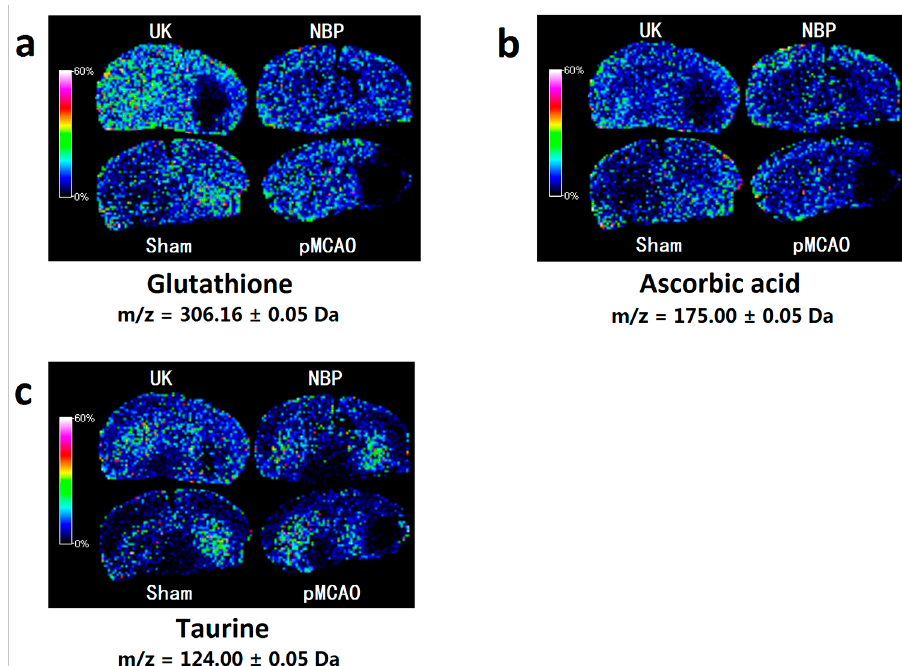
Figure 7. Dl-3-n-butylphthalide increased the antioxidant content in the rat model of pMCAO. MALDI–TOF–MS imaging of ( a ) glutathione; ( b ) ascorbic acid and ( c ) taurine. The spatial resolution was set to 200 µm. m/z: mass-to-charge ratio. Scale bar = 5 mm. n = 3. Sham: sham surgery group; pMCAO: pMCAO group; NBP: dl-3-n-butylphthalide-treated group; UK: urinary kallidinogenase- treated group.